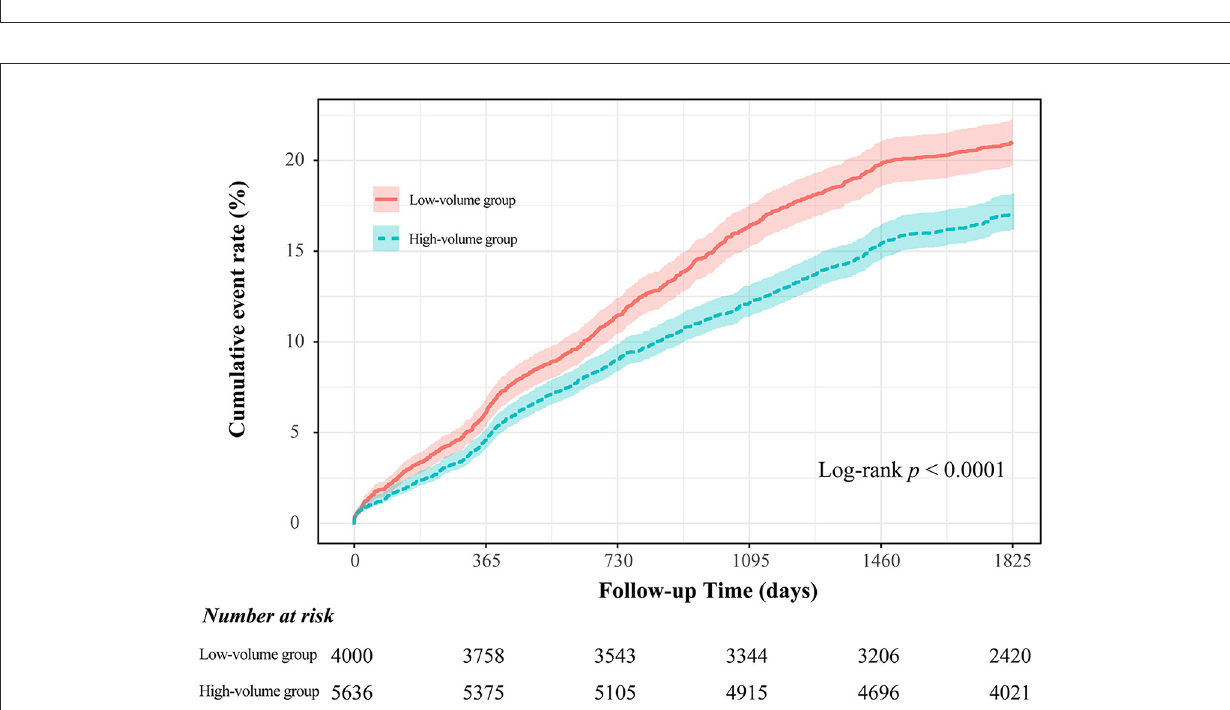
FIGURE6 Time-to-event curves for the MACE through 5-year follow-up in the full cohort.